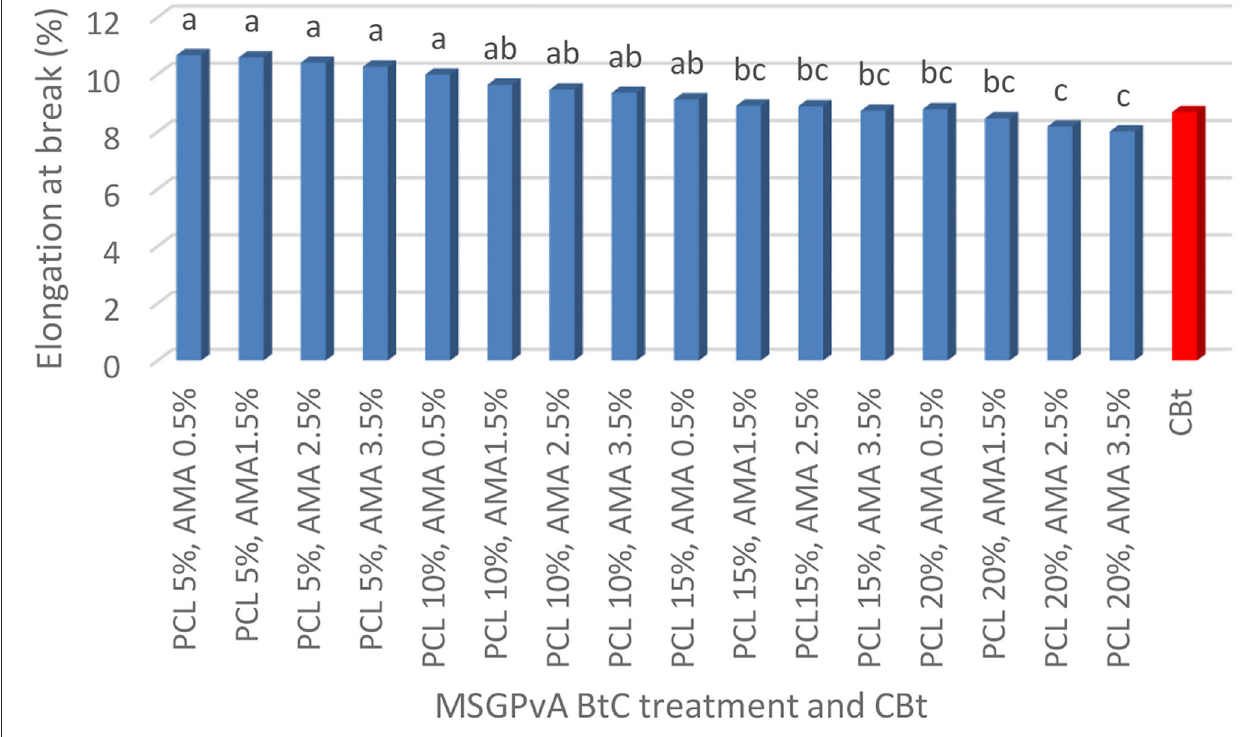
FIGURE 2 | Relationship of MSGPvA BtC and CBt with elongation at